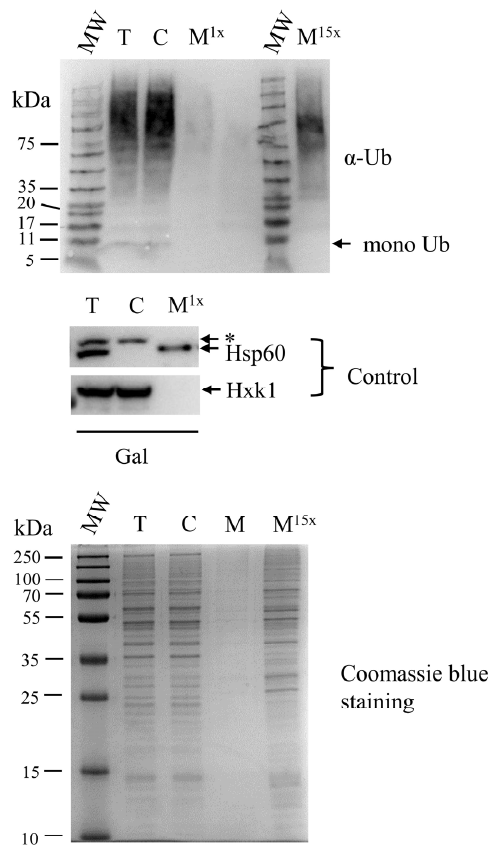
Figure 2. Ubiquitin conjugates are detected in mitochondrial fractions. ( Top panel ) Subcellular fractions probed for ubiquitin. Subcellular fractions were prepared from cells grown to logarithmic phase in galactose minimal medium. Mitochondrial fractions (M) corresponding to 1 × and 15 × cells, total (T) and cytosolic (C) fractions corresponding to 1 × cells were subjected to western blot employing anti-ubiquitin ( α -Ub) antibodies. ( Middle panel ) T, C, and M fractions were probed with control antibodies against Hsp60 and Hxk1, which are mitochondrial and cytosolic markers, respectively. *, the upper bands detected in T and C fractions are non-specific. ( Bottom Panel ) Subcellular fractions were subjected to 12.5% SDS-PAGE and Coomassie Blue staining. MW in the figure and figures elsewhere in the present study refer to molecular weight.